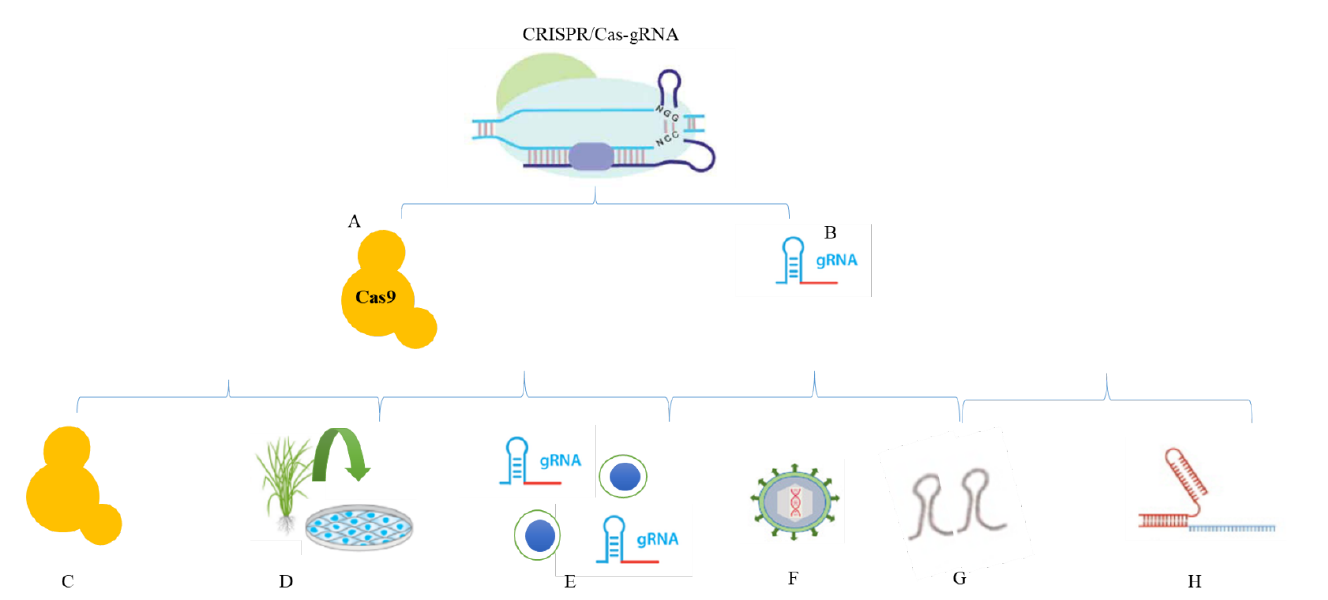
Figure 2. CRISPR/Cas9 cargos for delivery into cells. ( A ) Cas9 protein. ( B ) Trans-CRISPR RNA, sgRNA, and the Cas9– sgRNA complex can be delivered into cells using different methods. Some of the important methods are shown in the figure. ( C ) Cas9 protein delivery; ( D ) Cas9-expressing cell lines; ( E ) delivery of ribonucleoprotein (RNP); ( F ) delivery in the viral vectors/plasmids; ( G ) Oligos; ( H ) Delivery of the crRNA/tracrRNA complex as mRNA.